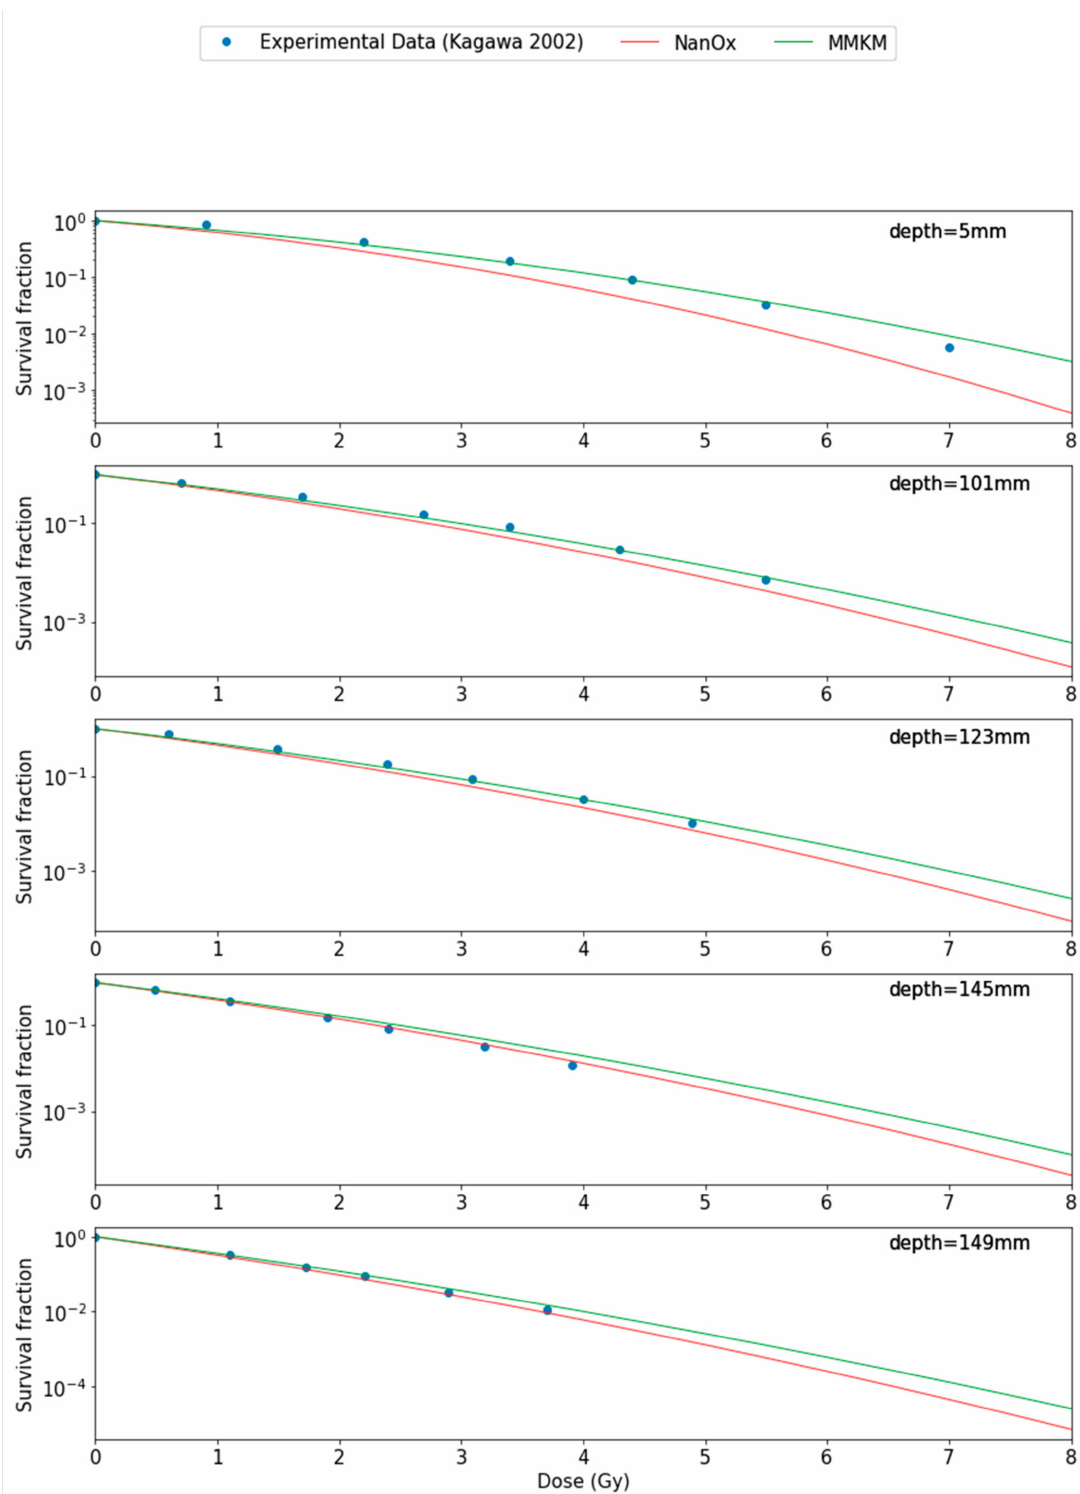
Figure 5. Survival fractions of HSG cells as a function of the dose using the BioDoseActor with the NanOx model (red curve) and the mMKM model (green curve) and experimental data from Kagawa et al. [25] for five positions in the SOBP: 5 mm, 101 mm, 123 mm, 145 mm, and 149 mm of the HIBMC 320 MeV/u carbon-ion beam